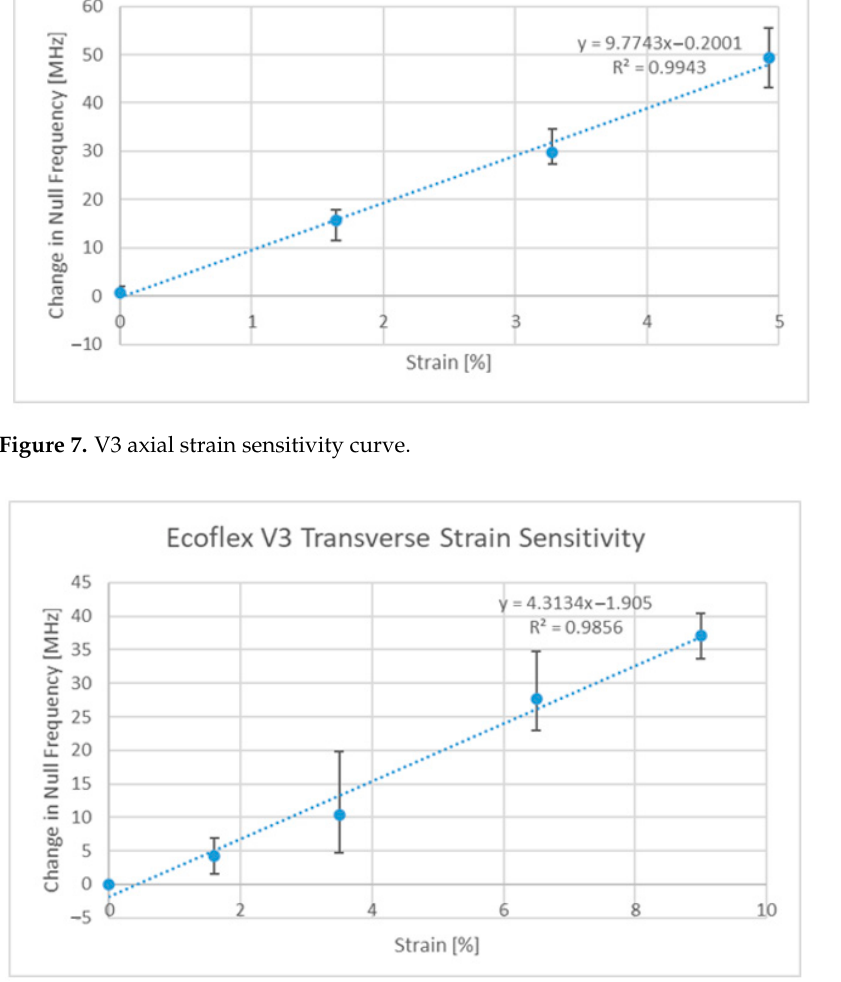
Figure 8. V3 transverse strain sensitivity curve.